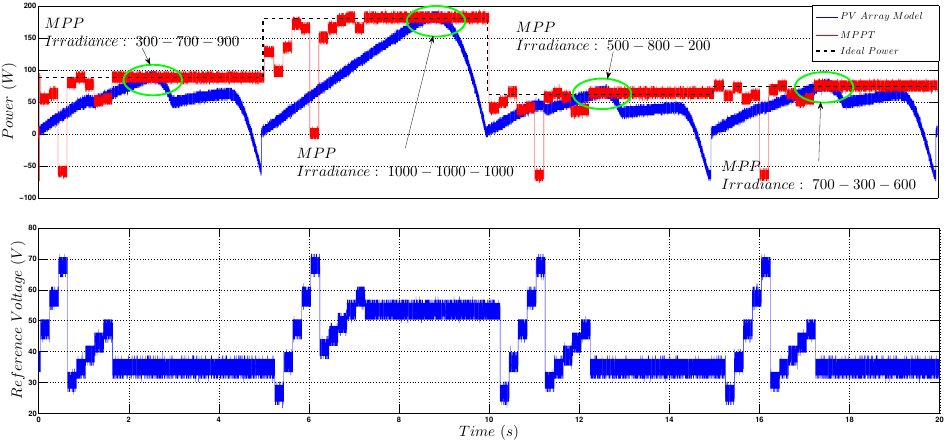
Figure 18. MPPT of the array of PV panel MSX60 with curves of the model generated by the speedgoat.